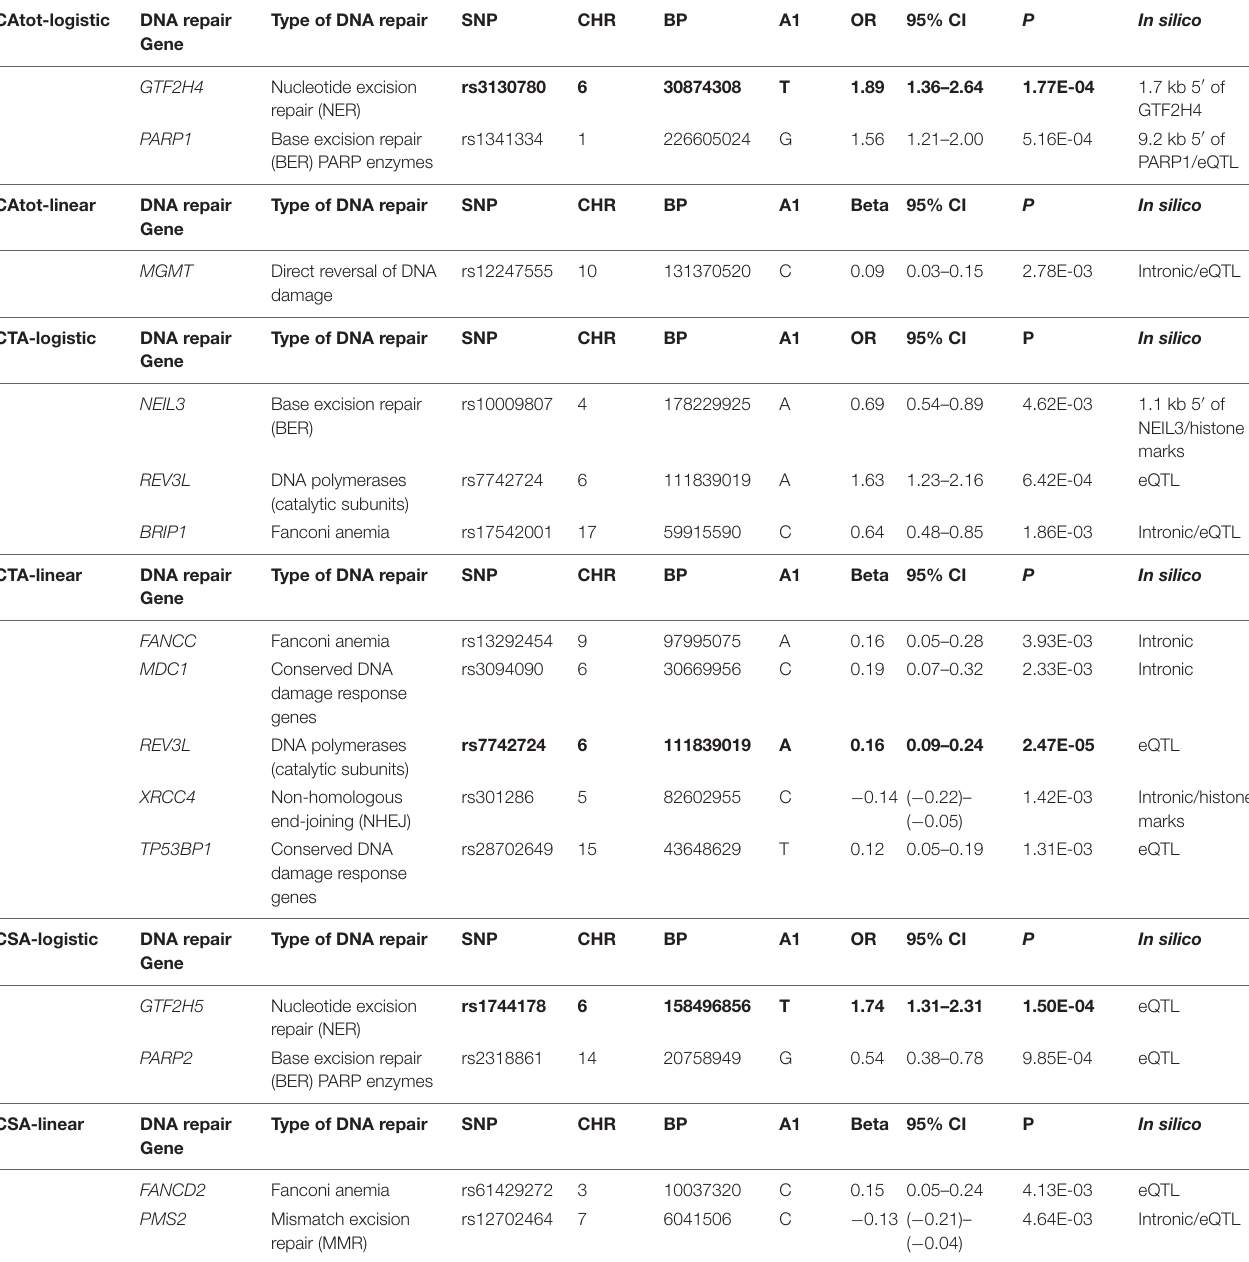
TABLE 3 | SNP associations with P -value ≤ 5 × 10 − 3 from logistic and linear regression analyses of three CA types (CAtot, CTA, and CSA).